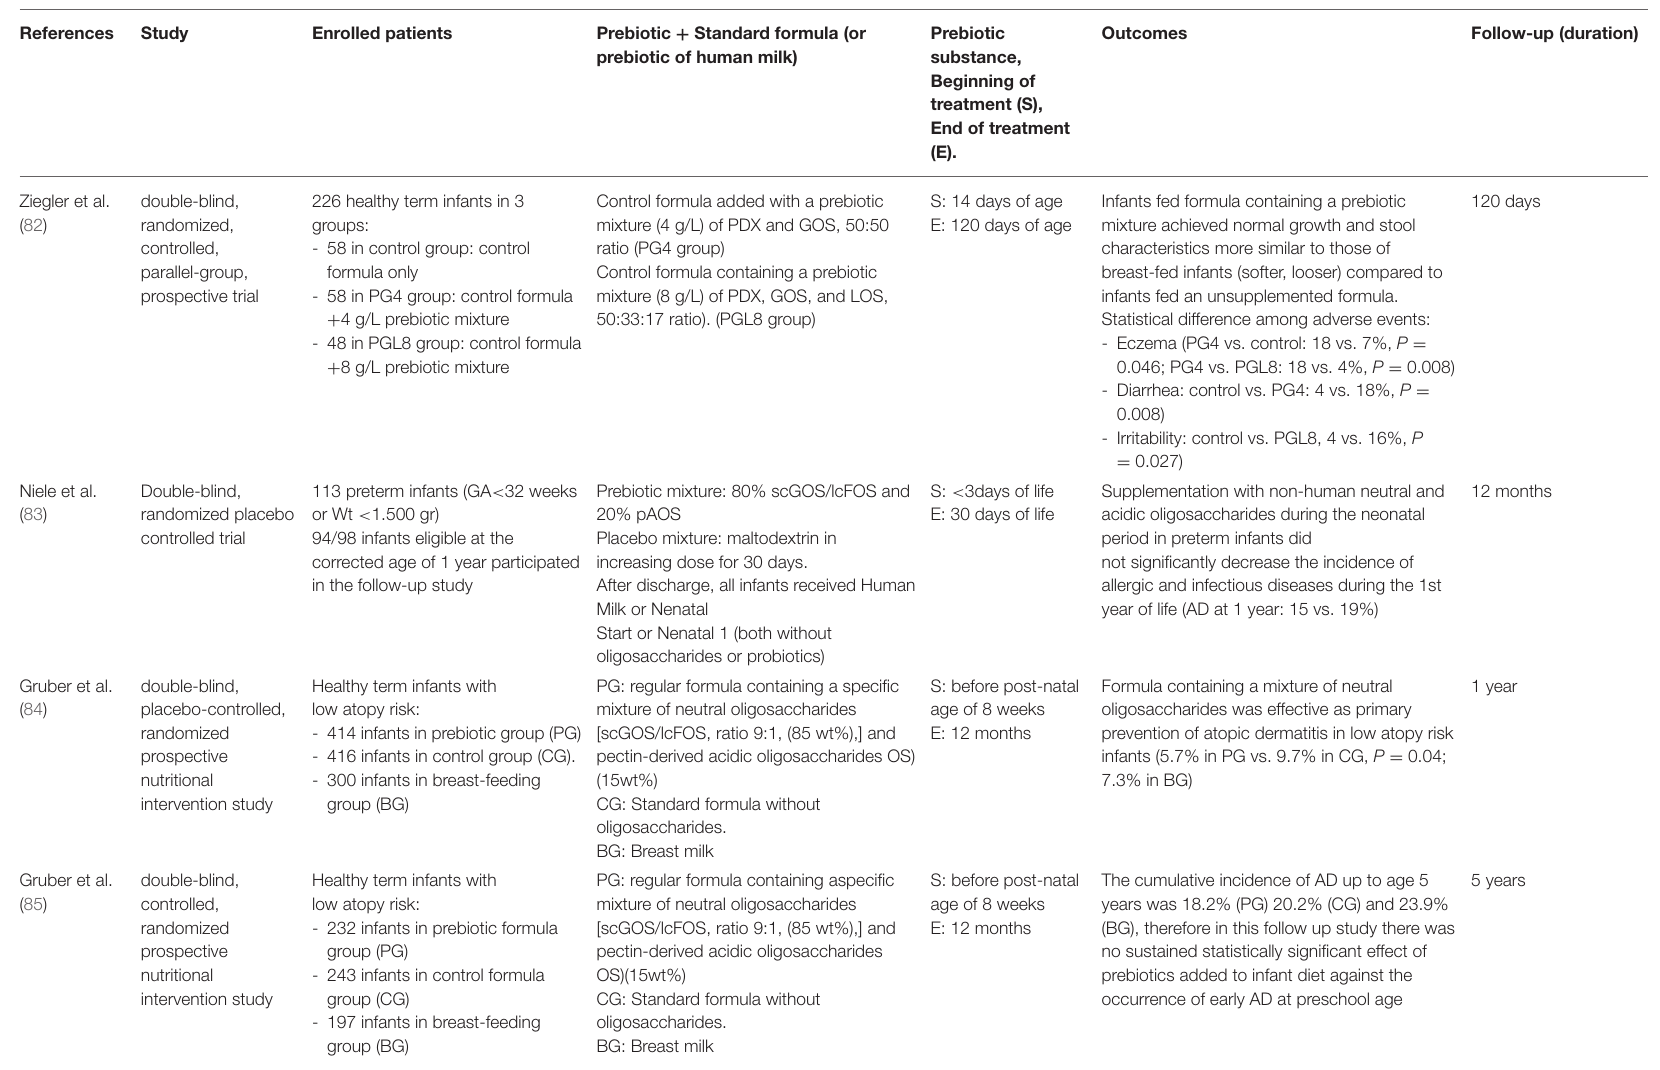
TABLE 1 | Prebiotics administration in prevention of allergic disorders. (A) Prebiotic + Standard formula (or prebiotic of human